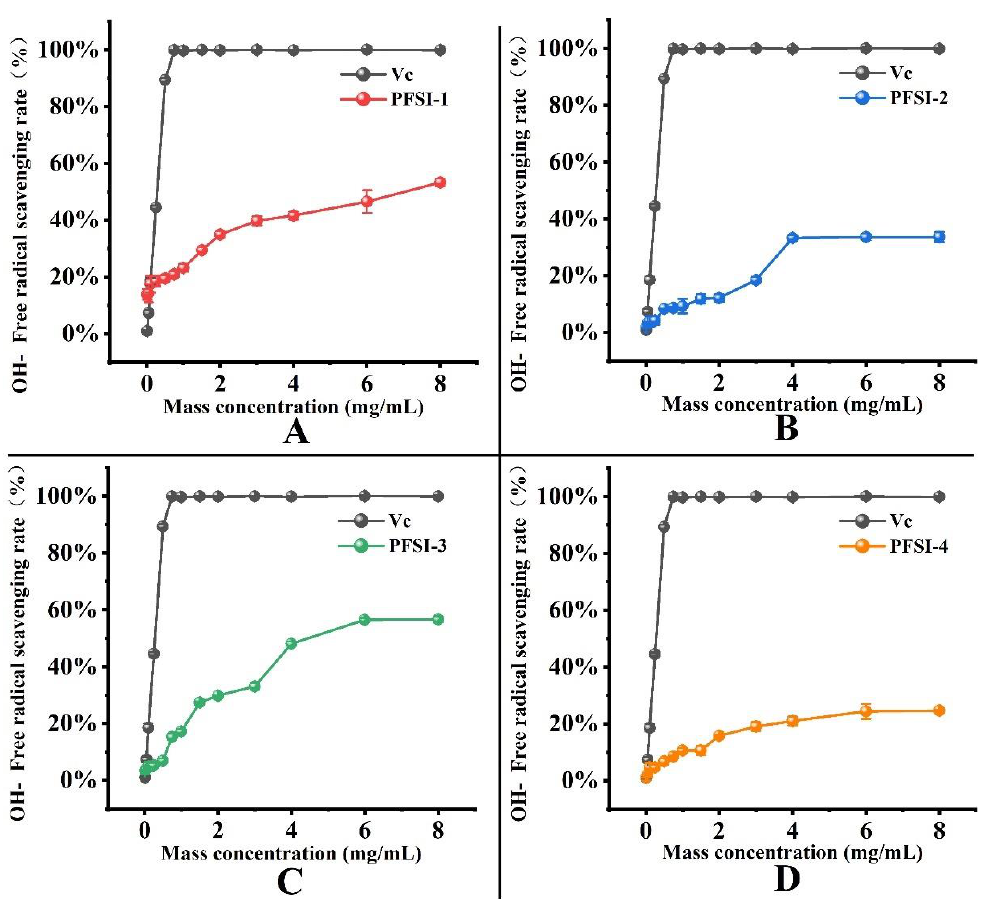
Figure 10. Comparison of the scavenging rate of · OH radicals by V C and PFSI · . (( A – D ) represent samples of PFSI-1, PFSI-2, PFSI-3 and PFSI-4, respectively).